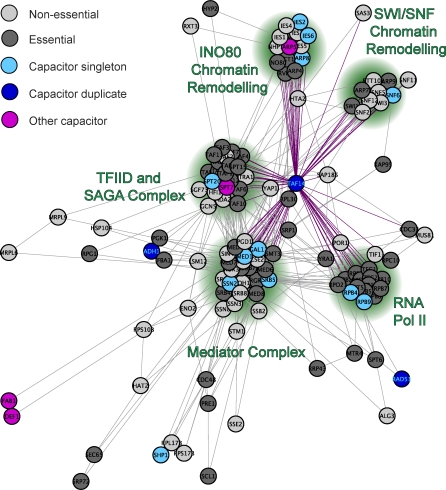
Singleton and duplicate capacitors occupy different locations in the PPI networkThe differences between singleton and duplicate capacitors are illustrated by the protein-interaction subnetwork surrounding complexes involved in transcriptional activation. Shown is a subnetwork of the affinity-capture mass spectrometry interaction network that was created using all proteins annotated to be in the Mediator complex and their first-degree interaction neighbors. The subnetwork was displayed using Cytoscape (http://www.cytoscape.org/), with nodes placed by spring embedded layout. Nineteen nodes with only one interaction have been removed for clarity. Colors represent nonessential proteins (light grey), essential proteins (dark grey), singleton capacitors (light blue), duplicate capacitors (dark blue), and capacitors that cannot be categorized as singletons or duplicates (purple). Singleton capacitors are likely to be found in highly interconnected complexes such as the Mediator transcriptional coactivation complex, RNA polymerase II, the SAGA and TFIID complexes, and chromatin remodeling complexes. Other members of these complexes tend to be essential genes or capacitors. Duplicate capacitors are highly connected and tend to interact with multiple complexes. Interactions of the duplicate capacitor TAF14 are highlighted in purple.